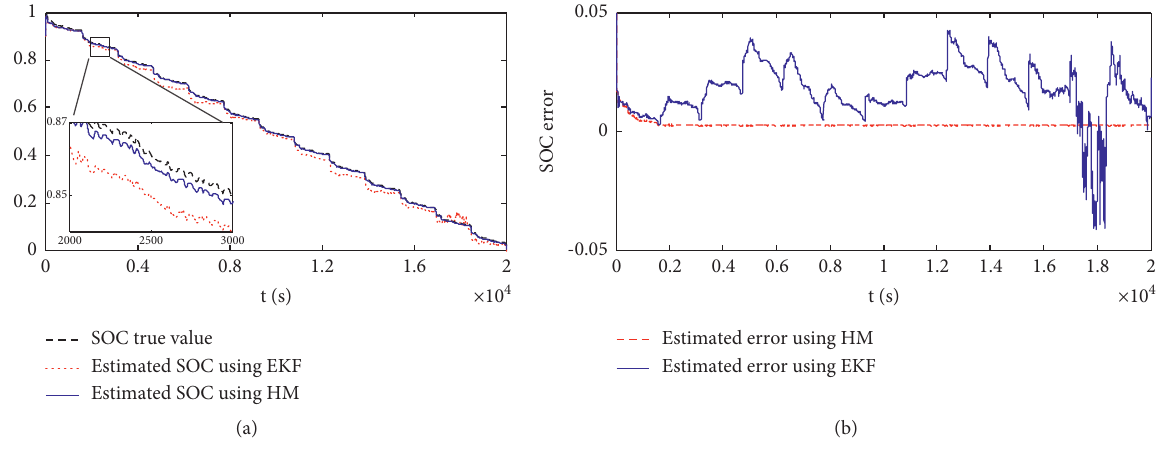
Figure 5: Estimated SOC results and their errors. (a) The estimated SOC. (b) The estimated SOC errors.